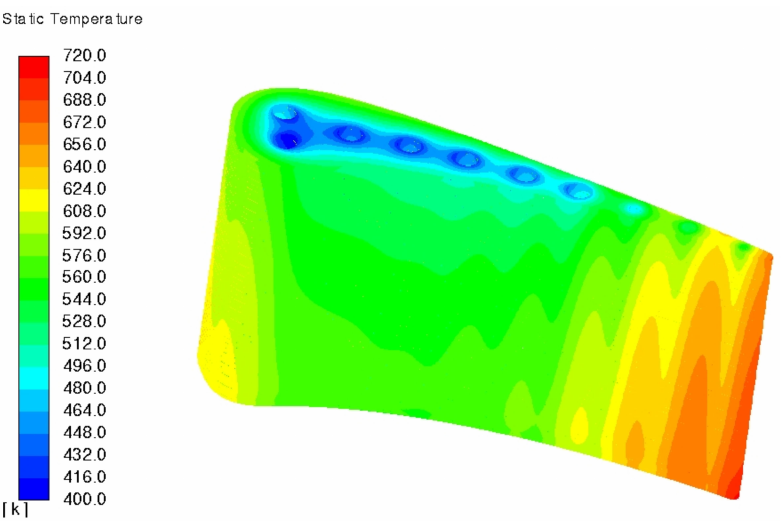
Figure 9. Pressure side temperature plot of model 1, run 158 ( k − ω SST).